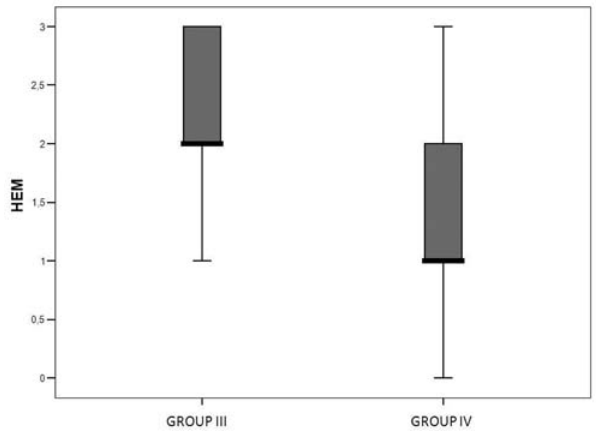
Figure 6 - Histological score of intraparenchymal hemorrhage (HEM) in steatotic control group III and steatotic SNAC group IV;